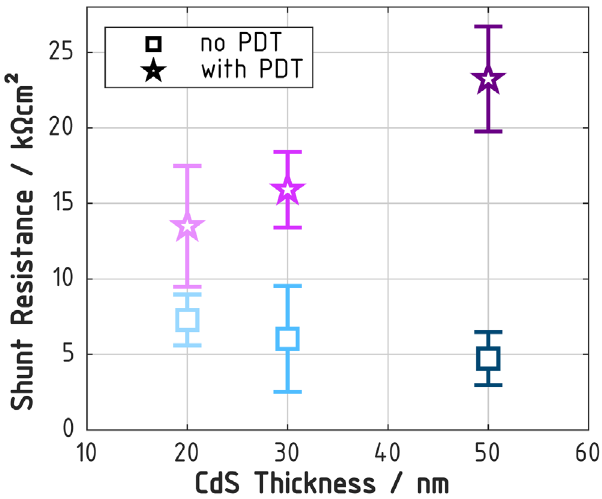
Fig. 4. Shunt resistances of the investigated cell types as extracted from dark IV curves. Mean values (symbols) and standard deviations (error bars) across 8 – 9 samples per cell type are